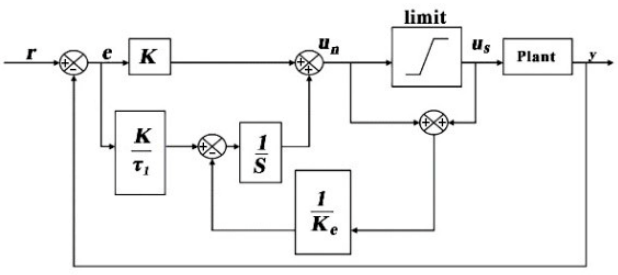
Figure 20. Back-calculation anti-windup Proportional Integral Derivative (PID)